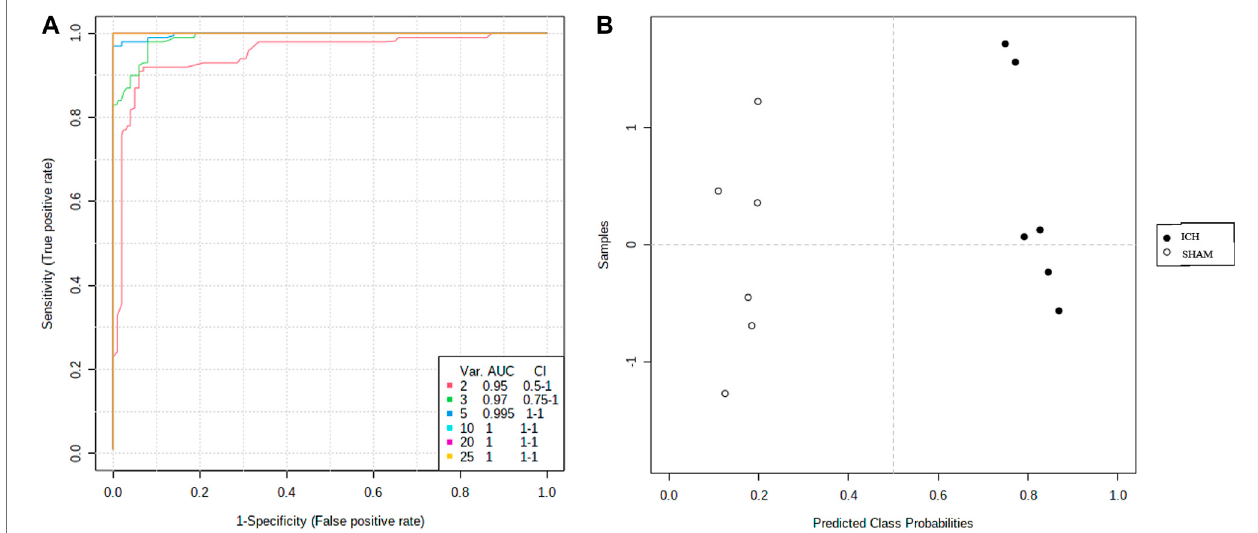
FIGURE 8 | Comparison of the sham and ICH groups of serum samples from multiple ROC curve